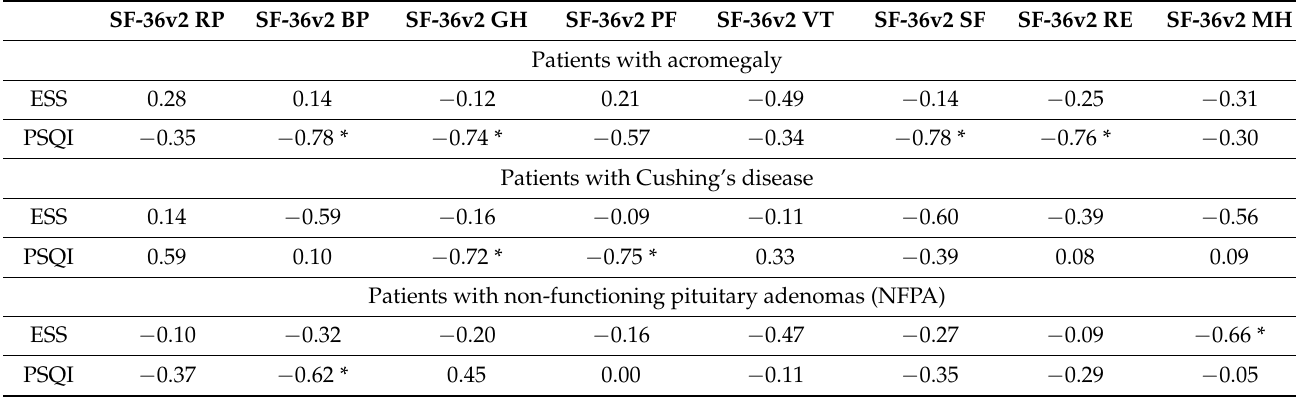
Table 2. Relationship between Epworth Sleepiness Scale (ESS) scores, Pittsburgh Sleep Quality Index (PSQI) scores, and Short-Form Health Survey version 2 (SF-36v2) scores in patients with acromegaly, patients with Cushing’s disease, patients with non-functioning pituitary adenomas (NFPA), patients with presence of optic chiasm compression (POCC), and patients with absence optic chiasm compression (AOCC) in